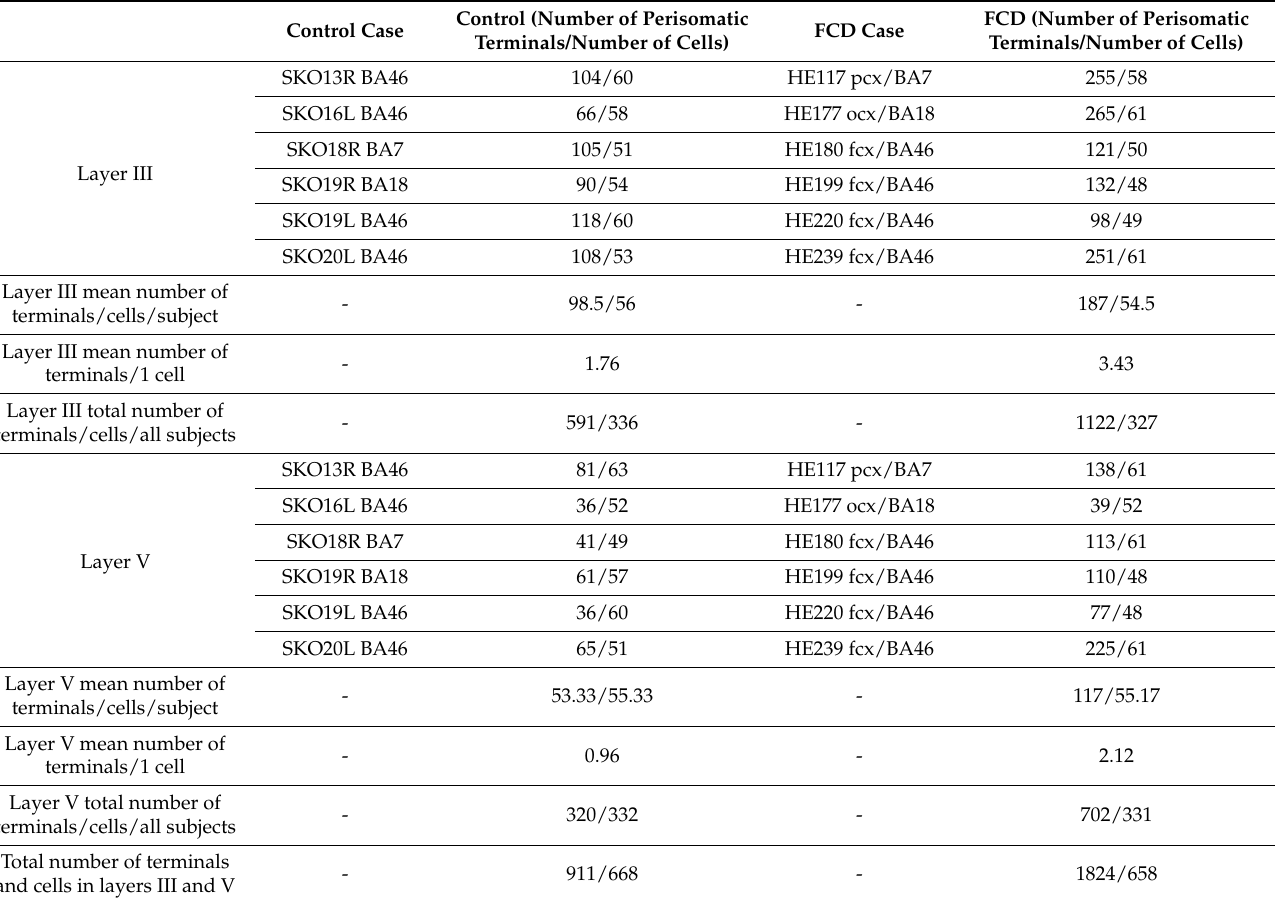
Table 2. Number of cells and terminals counted in the quantitative analyses of the perisomatic input.